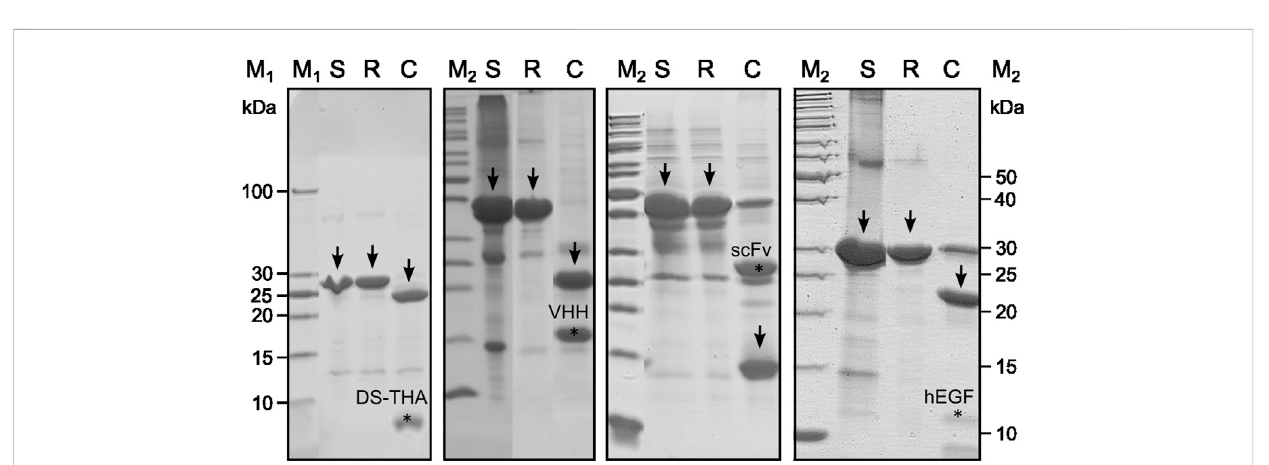
FIGURE 1 SDS-PAGE analysis (Coomassie-stained) of Switchtag peptein fusion proteins from solubilization to the cleavage reaction. Arrows indicate the Switchtag peptein fusion proteins after solubilization from IBs (S) and the refolding step (R) and the Switchtags after protease cleavage (C). Target signals were marked ( p ) and found for all pepteins.